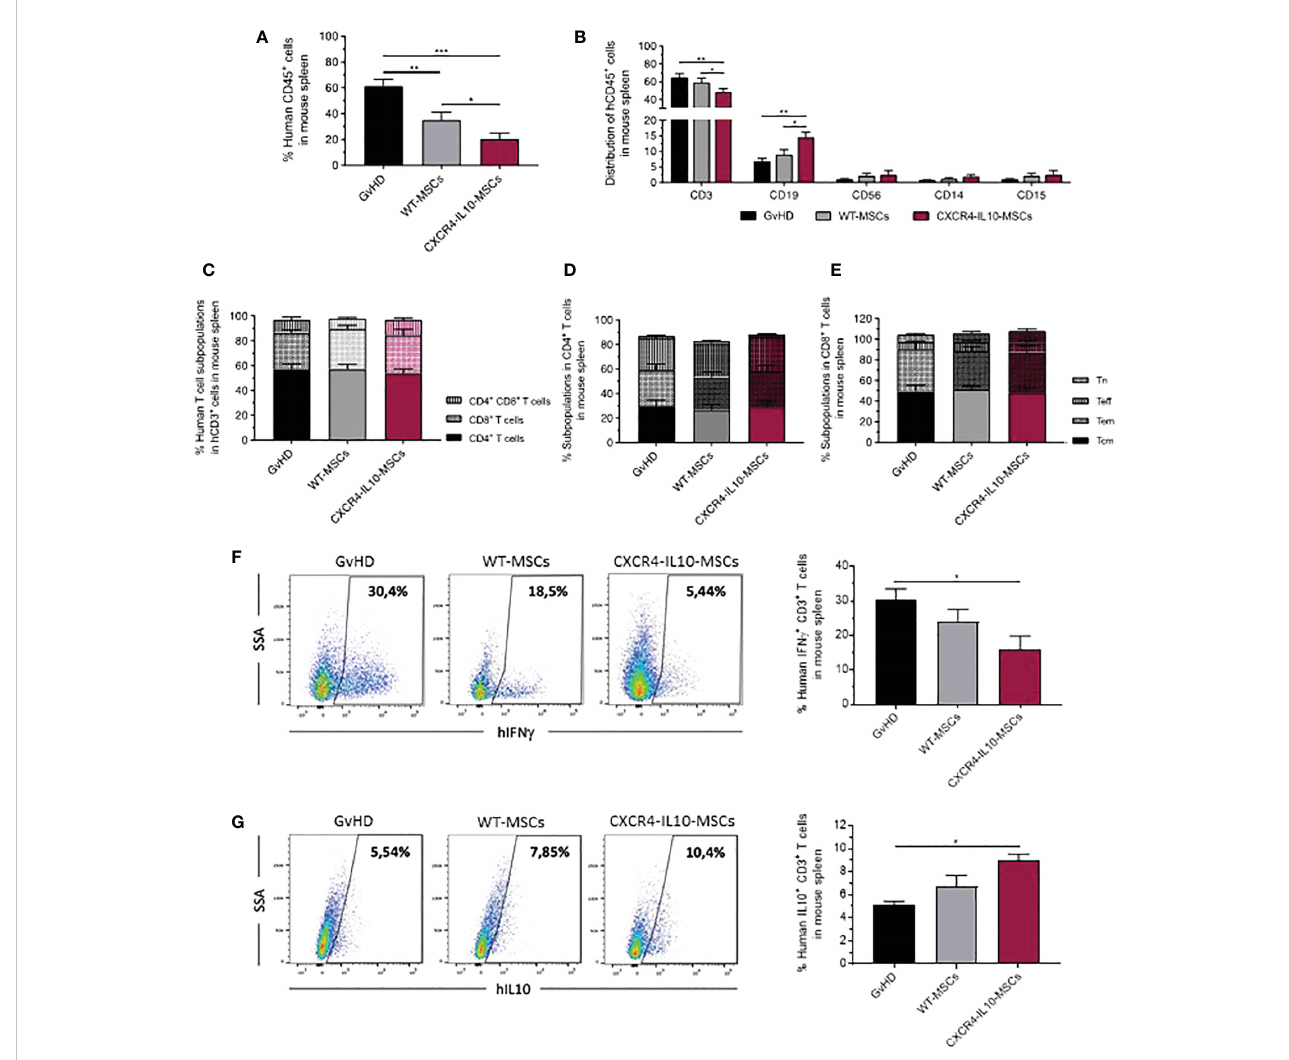
FIGURE 6 Analysis of human T cells in the spleen of humanized GvHD recipients treated with WT-MSCs or CXCR4-IL10-MSCs. (A) Percentage of hCD45 + cells in fi ltrating in the spleen of transplanted NSG recipients treated with WT- or CXCR4-IL10-MSCs. (B) Composition of hCD45 + cells characterized in panel (A) . (C) Distribution of CD4 + , CD8 + and CD4 + CD8 + cells present in the T cells determined in panel (B) . (D) Frequency of naïve (Tn), effector (Teff), effector memory (Tem) and central memory (Tcm) subpopulations present in hCD4 + and (E) hCD8 + T cells. (F) Analysis of the percentage of Th1 cells (CD3 + IFN g + T cells) and (G) Th2 T cells (CD3 + IL10 + cells) present in the spleen of transplanted recipients. Analyses were conducted three weeks after transplantation of NSG recipients. Each bar represents the mean ± SEM corresponding to 10-20 mice per group. *p < 0.05; **p < 0.01; ***p <